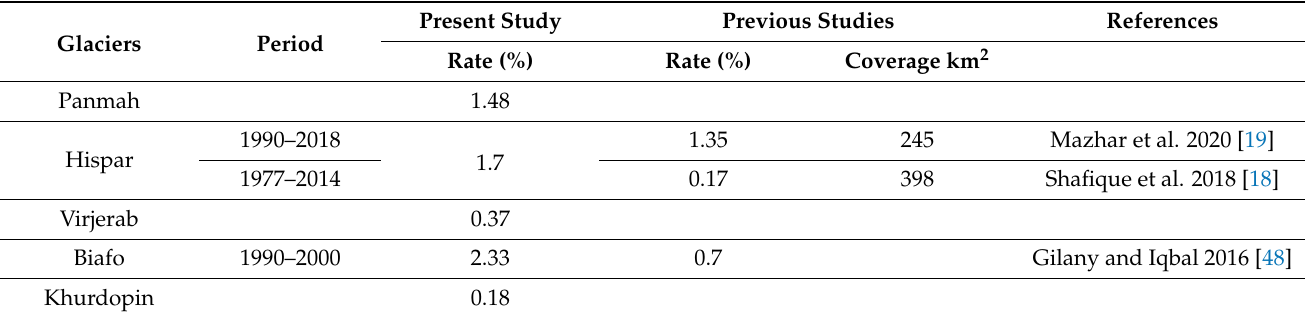
Table 6. Comparison of the glaciers studied in this research with previous